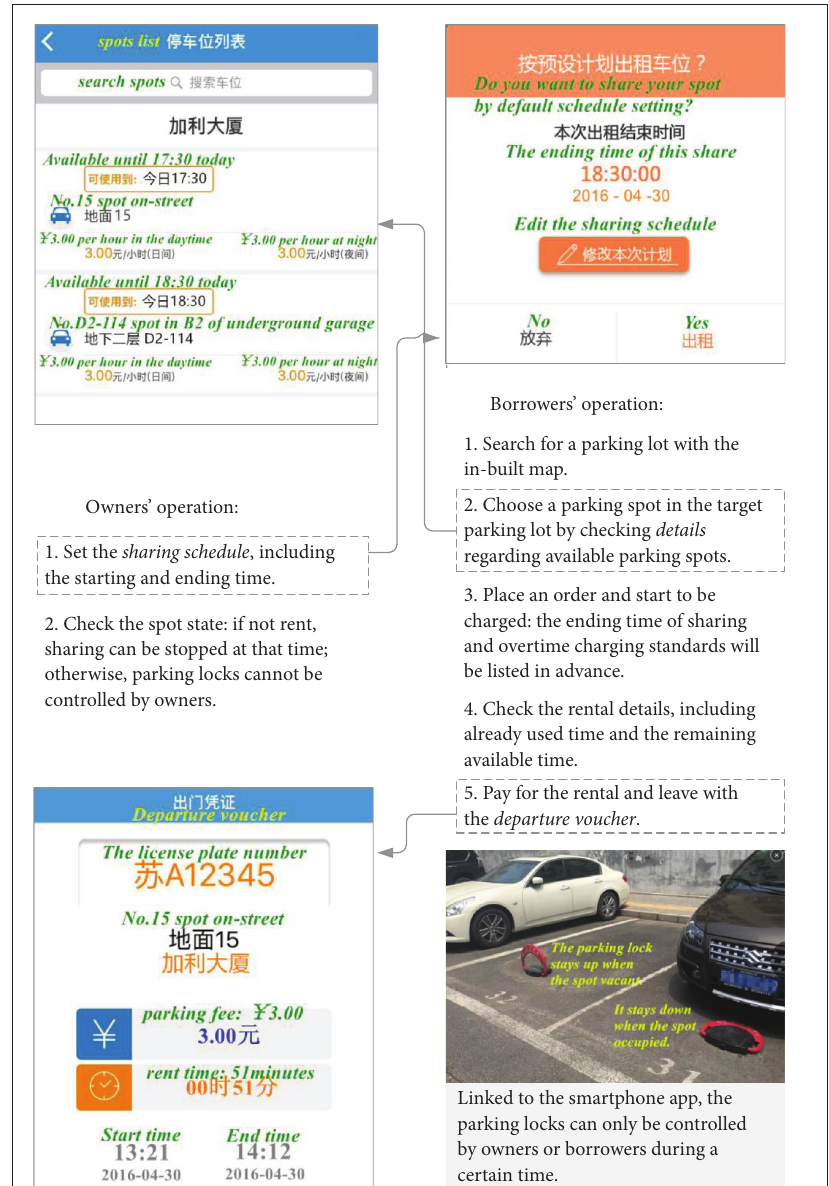
Figure 1: Operation of DParking app and parking